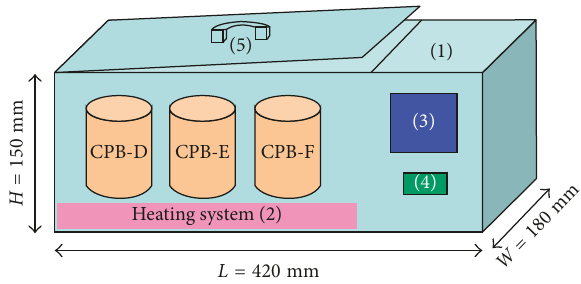
Figure 3: Schematic diagram for the temperature water bath samples CPB-D, CPB-E, and CPB-F. (1) Reactor of stainless steel; (2) heating system; (3) digital temperature display and micro- computer control; (4) power switch; (5)